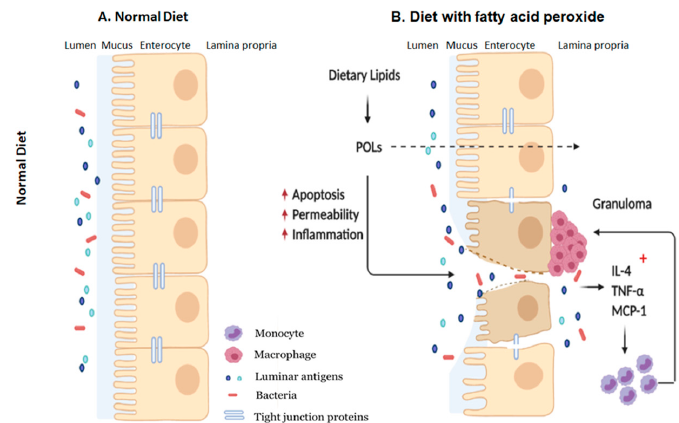
Figure 7. Schematic representation of how dietary POLs interact with the intestinal mucosa. Dietary lipids could be oxidized during normal GI transit to the small and large intestines. Dietary peroxide (13-HPODE) either directly interact with IE cells or diffuse passively. Dietary POLs induce an inflammatory response in the intestine by increasing the expression of pro-inflammatory cytokines IL-4, TNF- α , and MCP-1, that lead to apoptosis, activate immune cells and enhance in monocyte / macrophage recruitment. Apoptosis increases intestinal permeability, which enables luminal toxins / antigens to enter the lamina propria, further inducing inflammation by resident immune cells. TNF- α , Tumor necrosis factor alpha; MCP-1, Monocyte chemoattractant protein-1; IL, Interleukin; POL: Peroxidized